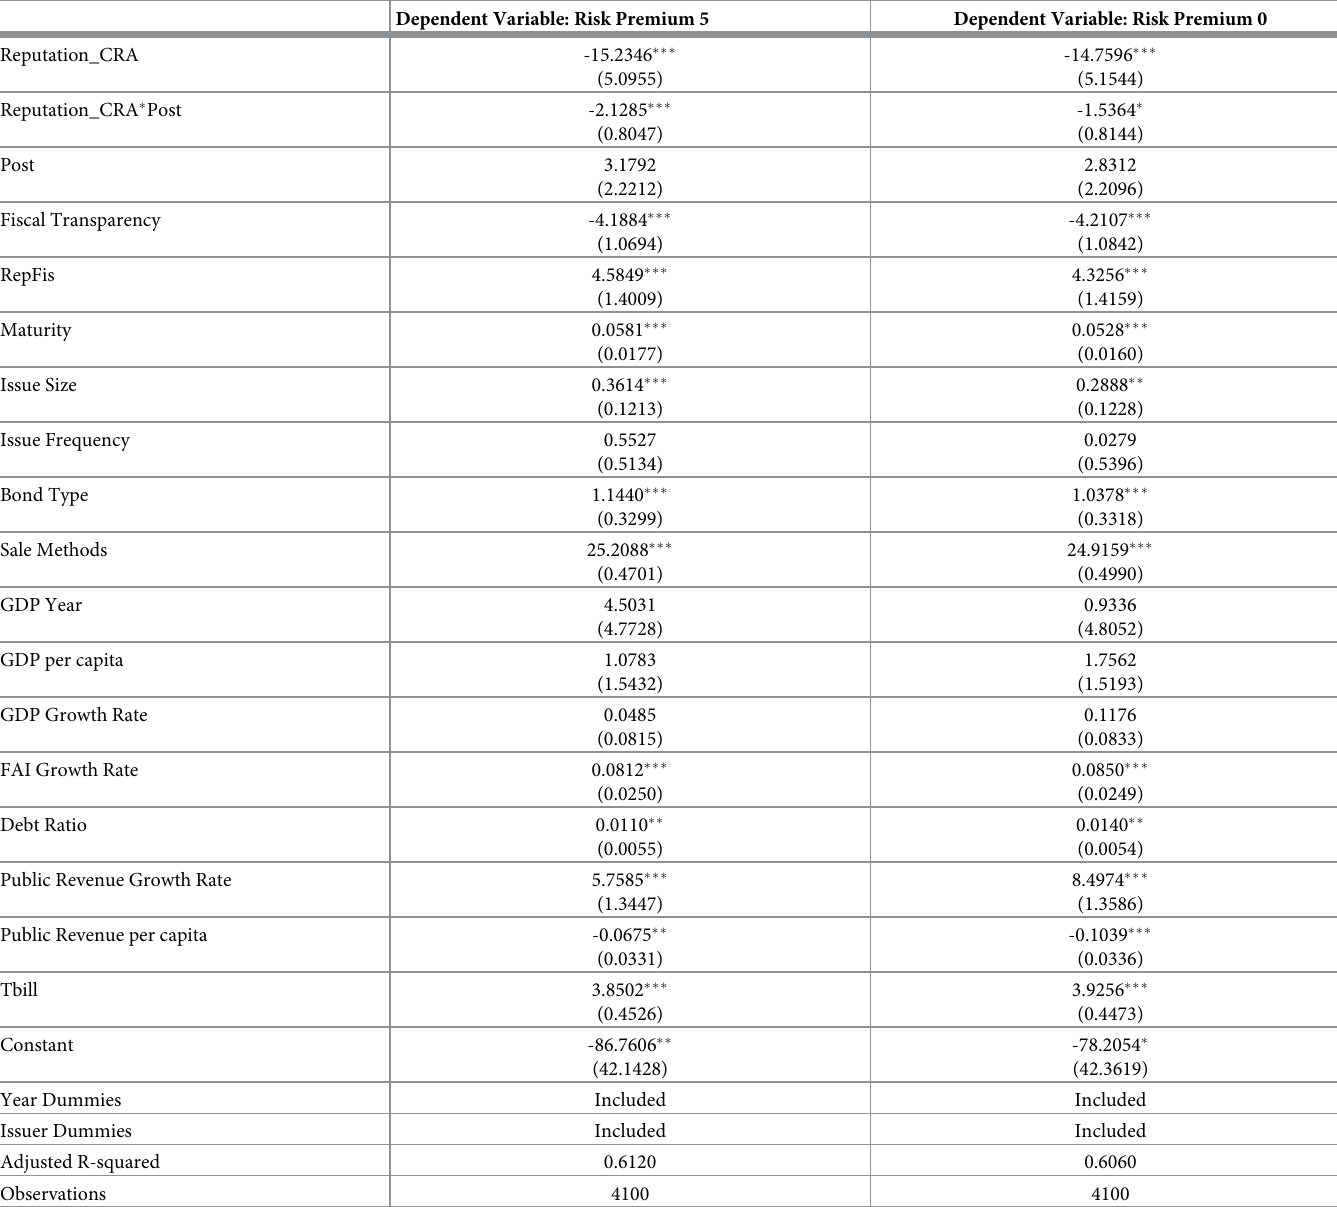
Table 11. Difference-in-differences OLS regression results. This table reports the regression results based on Eq